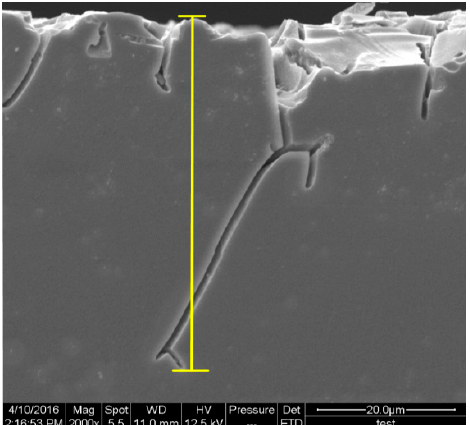
Figure 3. Profile measurement for subsurface crack depth determination.